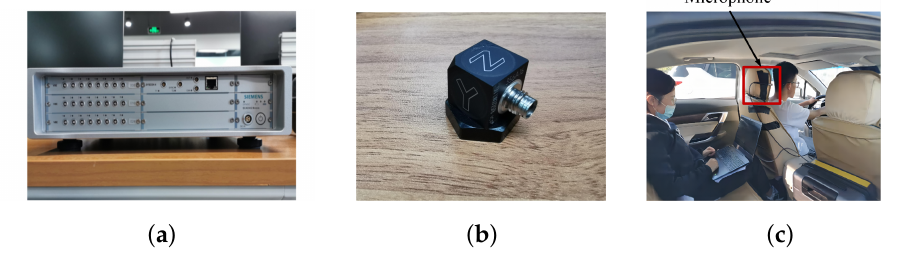
Figure 1. Test equipment and noise test site. ( a ) Siemens LMS equipment. ( b ) Vibration sensor. ( c ) Interior noise test.